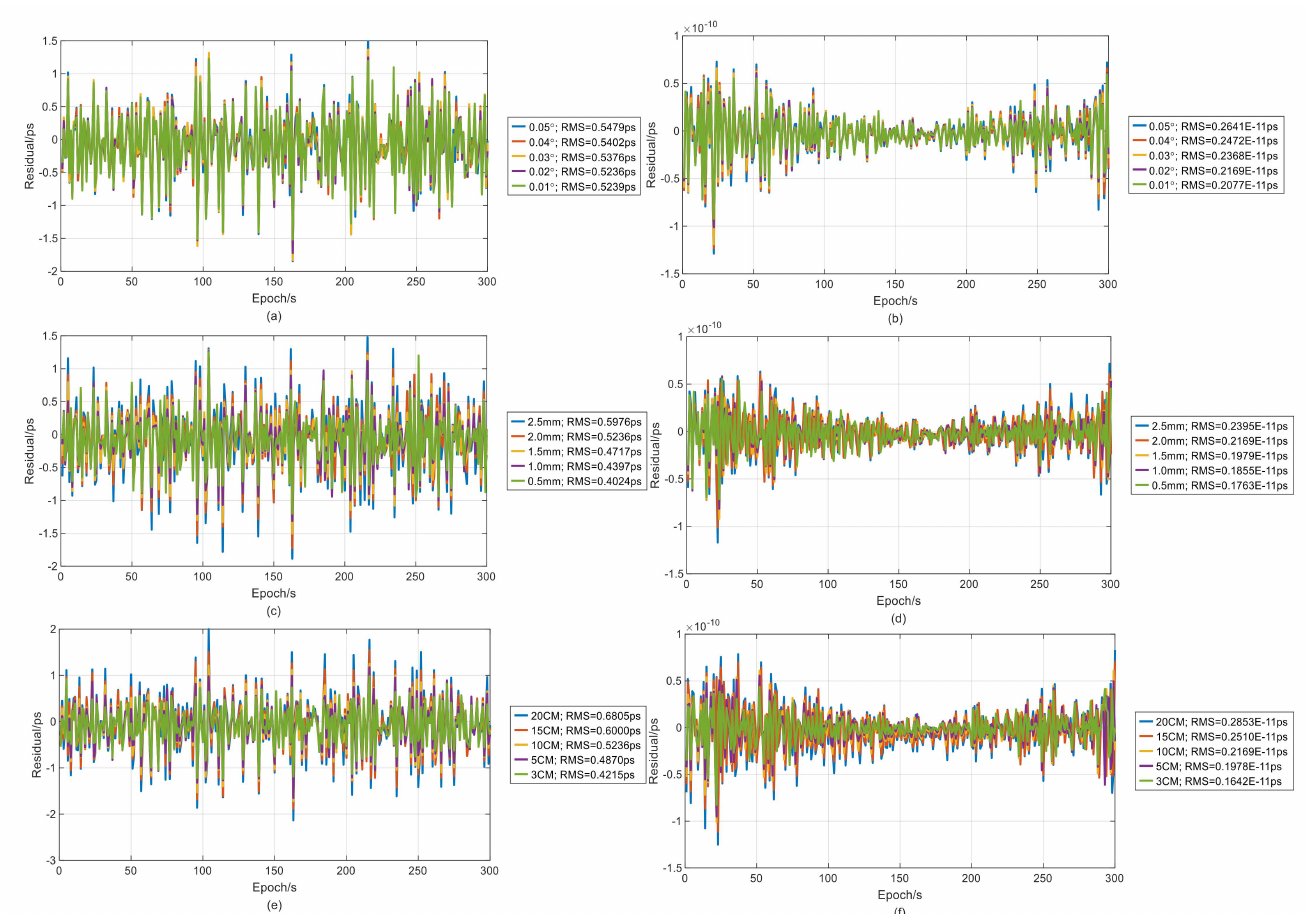
Figure 6. The influence of different orbit errors on the accuracy of the relativistic correction model. ( a , b ) The influence of different attitude errors on periodic relativity and gravitational time delay correction, respectively. ( c , d ) The influence of different phase center calibration errors on periodic relativity and gravitational time delay correction, respectively. ( e , f ) The influence of different POD errors on periodic relativity and gravitational time delay correction,